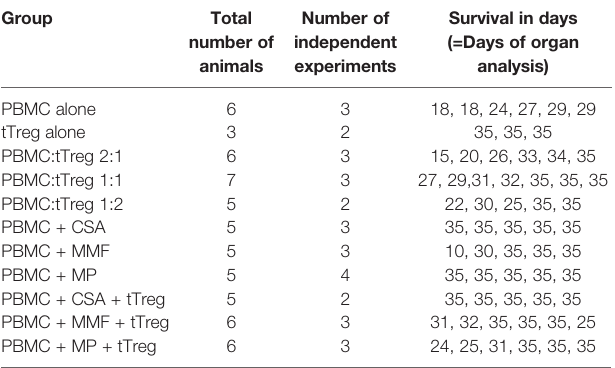
TABLE 1 | Summary of experimental setup. Group Total